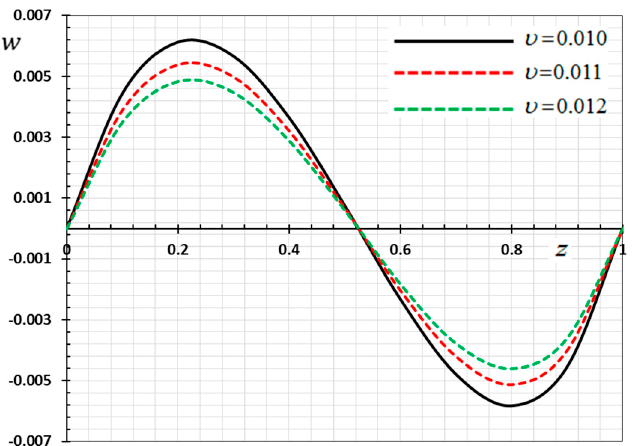
Figure 14. Variation of displacement 𝑤 versus 𝑧 for different gradient coefficient 𝑁 . Materials 2020 , 13 , x FOR PEER REVIEW